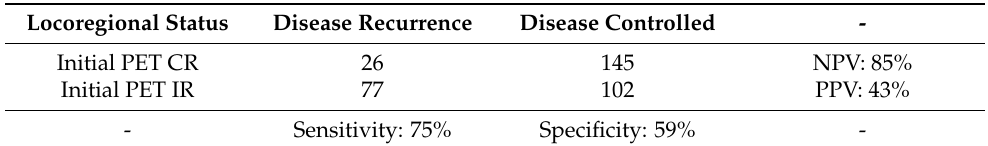
Figure 3. Kaplan–Meier curves comparing patients following initial PET/CT imaging with a complete response versus an equivocal response: ( A ) Freedom from progression, ( B ) disease-specific survival, and ( C ) overall survival Table 2. Predictive values of initial post-treatment PET/CT for persistent locoregional and distant disease. Locoregional Status